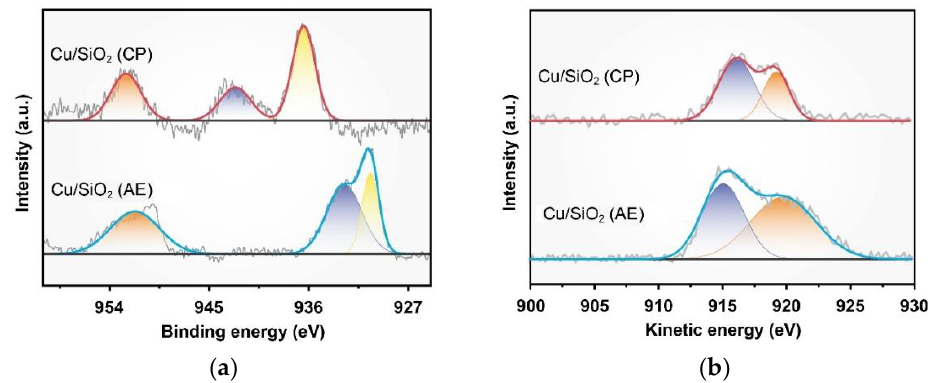
Figure 5. ( a ) XPS spectra of the Cu/SiO 2 catalysts; ( b ) Cu LMM Auger spectra of the Cu/SiO 2 cata- lysts.